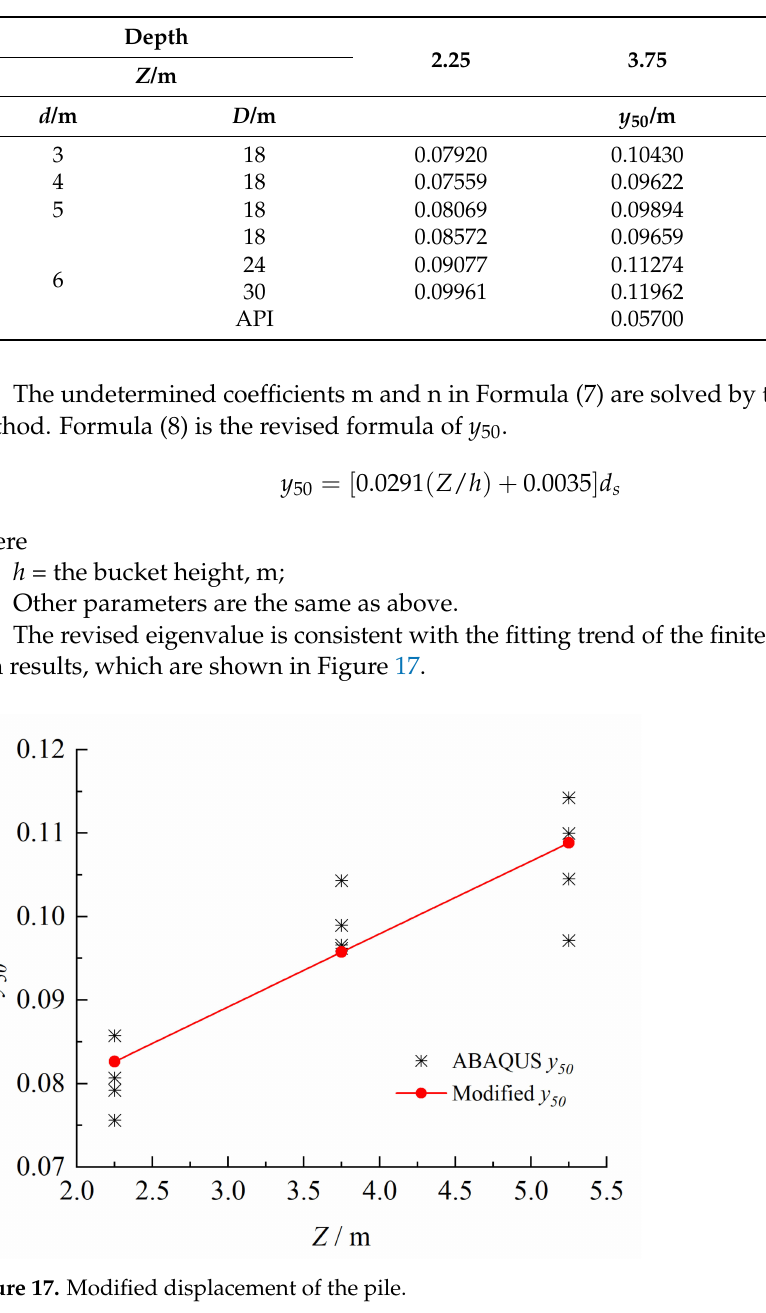
Table 9. Displacement of the pile.